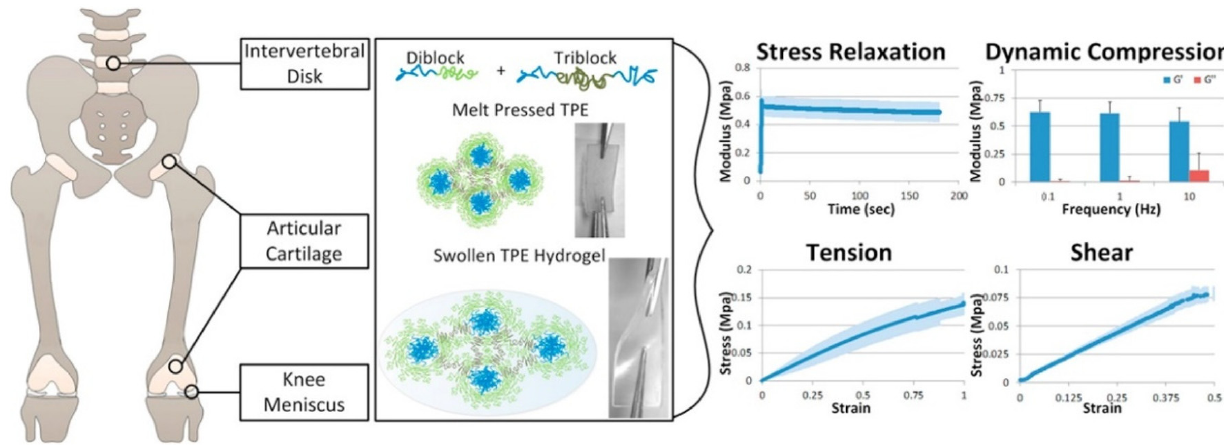
Figure 12. Mechanical viability of a thermoplastic elastomer hydrogel as a soft tissue replacement material. Reproduced from [168] with permission. Copyright 2018 Elsevier Ltd. All rights